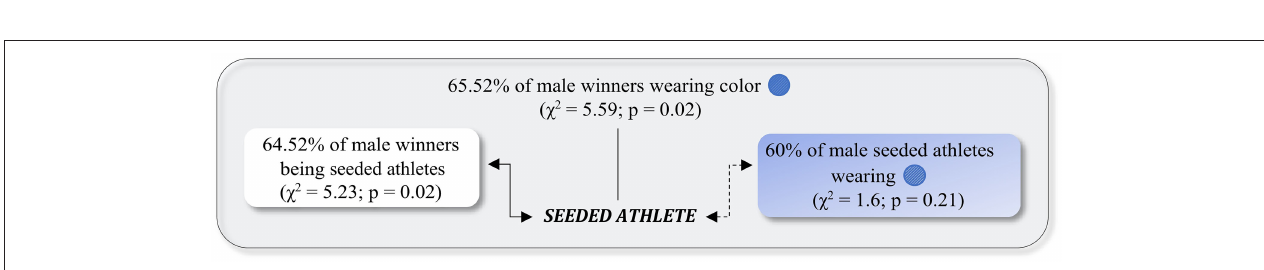
FIGURE 1 | Relationship between the color of the protectors and the result of the match, considering seeded athletes as a moderation factor, for male athletes in flyweight, Samsun 2015 World Grand Prix Series 2. Continuous lines indicate significant relationships.